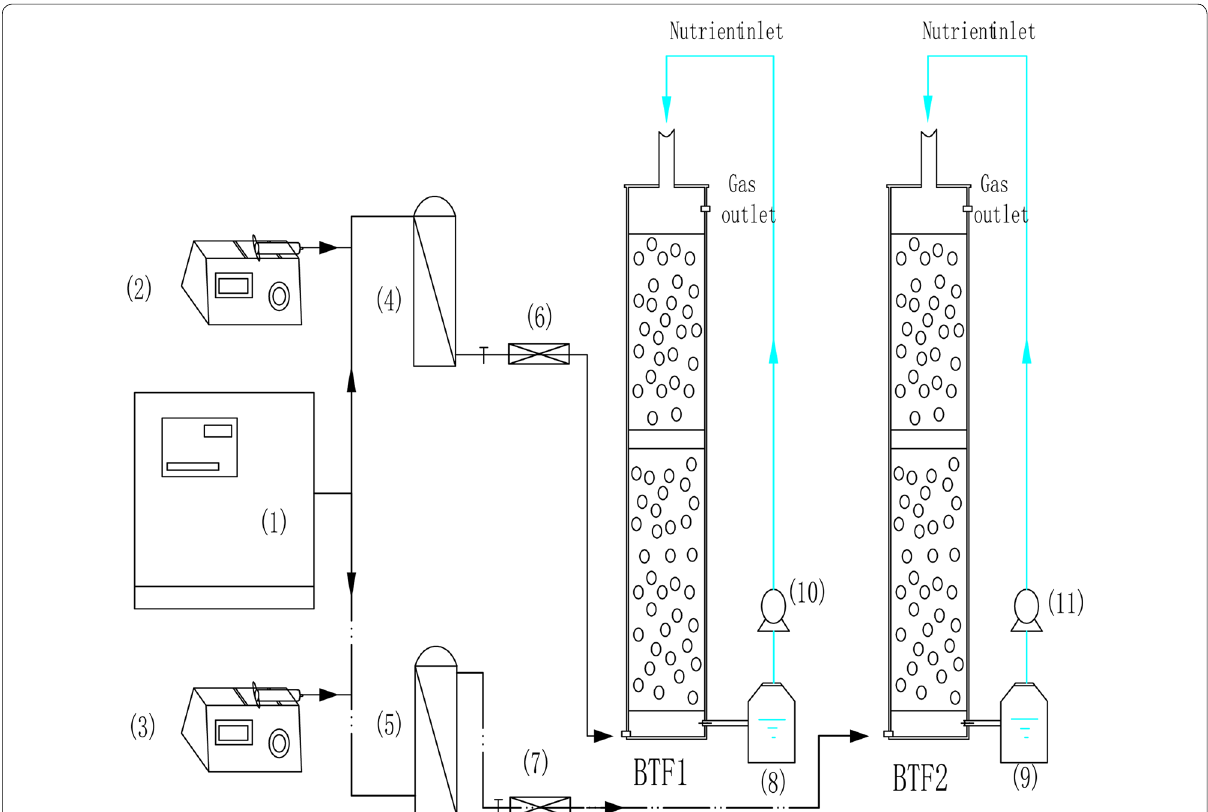
Table 1 Compounds used in the experiment and their inlet concentrations Stage Days Inlet concentration (mg/m 3 ) Toluene Ethyl benzene p ‑Xylene m ‑Xylene I